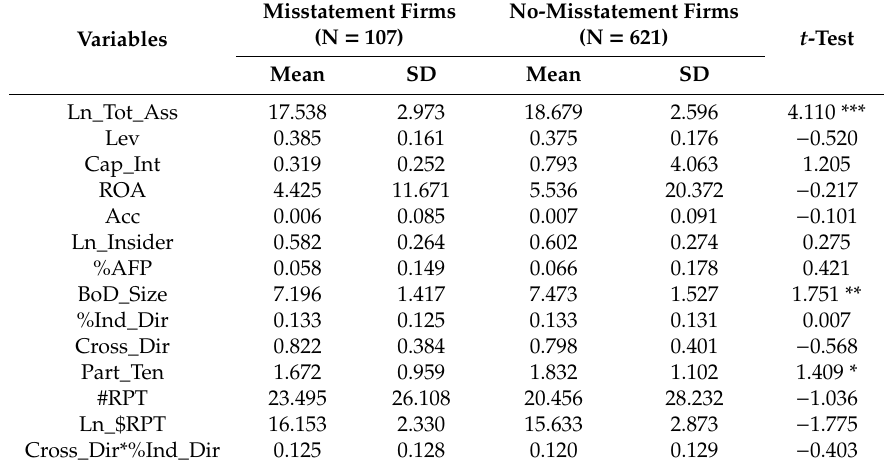
Table 3. Comparison of misstatement versus no-misstatement firms.